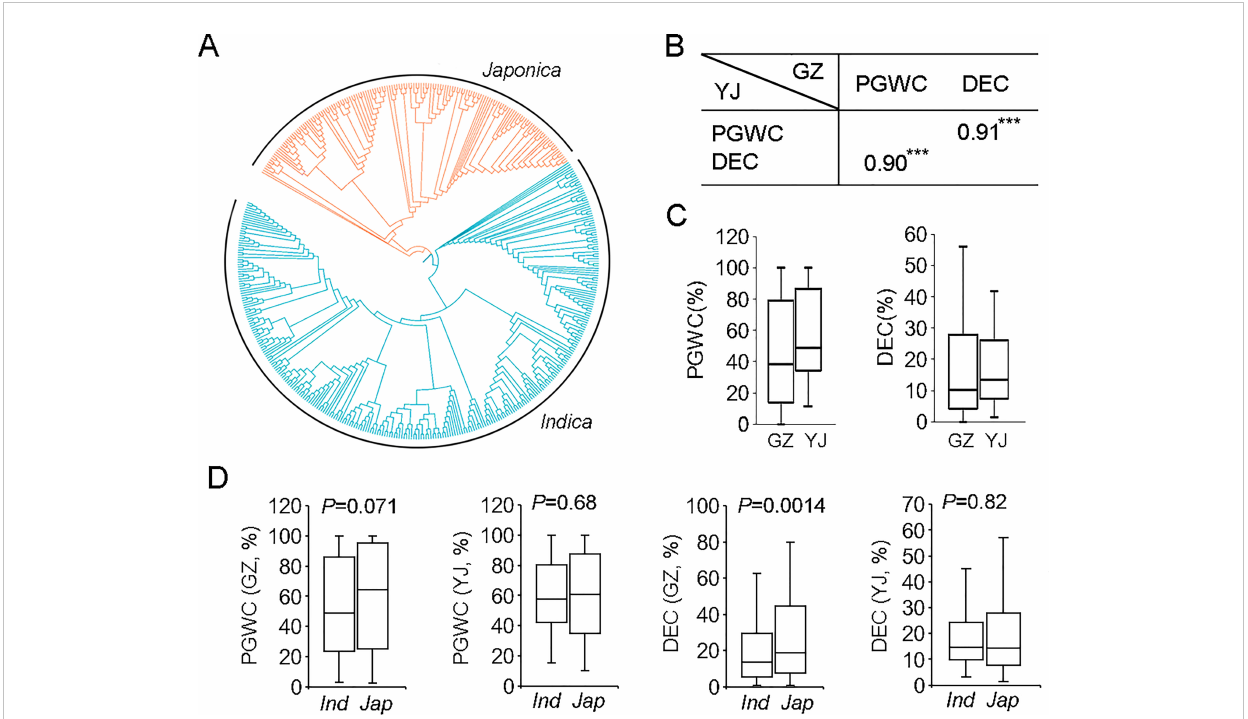
FIGURE 1 The phylogenetic tree and phenotypic comparison of 450 rice accessions used in this study. (A) The phylogenetic tree of 450 rice accessions. (B) Correlation analysis of PGWC and DEC in two environments. ***p<0.001. (C) Box plots of PGWC and DEC in two environments. (D) Phenotypic comparison between indica and japonica rice. Statistical comparison was performed by one-side t -test. GZ, Guangzhou; YJ, Yangjiang; PGWC, Percentage of grains with chalkiness; DEC, Degree of endosperm